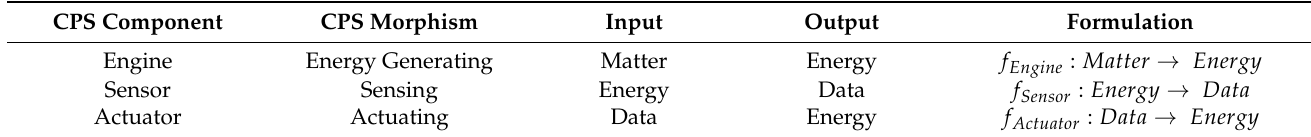
Table 3. Examples of cyber-physical system morphisms. CPS Component CPS Morphism Input Output Formulation Engine Energy Generating Matter Energy f Engine : Matter → Energy Sensor Sensing Energy Data f Sensor : Energy → Data Actuator Actuating Data Energy f Actuator : Data →